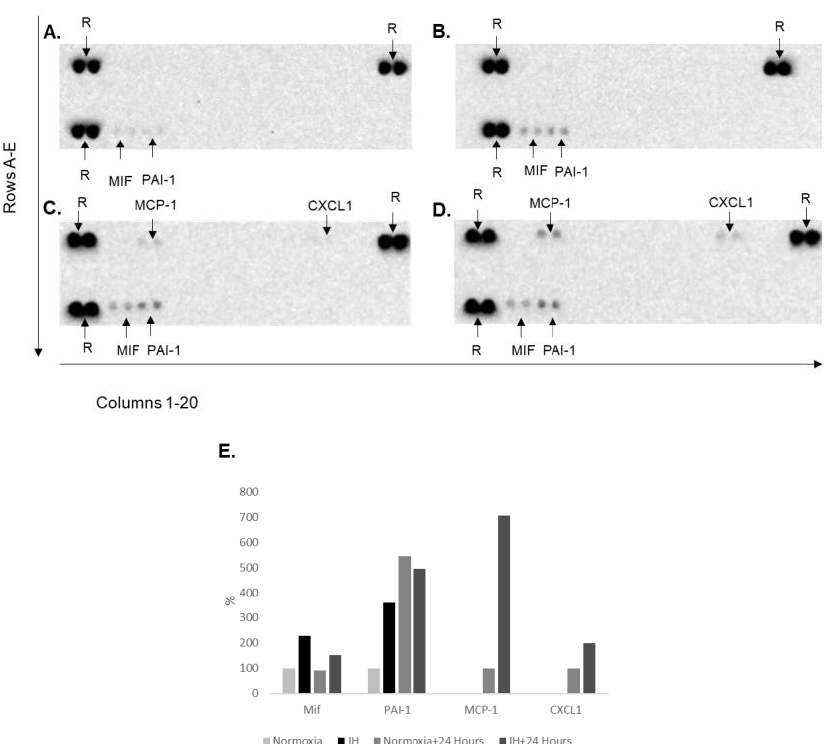
Figure 4. Specific protein secretion following IH in hESC-CMs. Supernatants following normoxia (21%O 2 , 37 °C) or IH = 1% O 2 , 37 °C for 12 h (60 Cycles) and 24 additional hours in normoxia conditions. R arrows are reference points. All the membranes were exposed to the same exposure parameters during densitometry: ( A ) membrane following 12 h normoxia; ( B ) membrane following 12 h intermittent hypoxia; ( C ) membrane following a total of 36 h normoxia; ( D ) membrane following 12 h intermittent hypoxia followed by 24 h normoxia; ( E ) imageJ densitometry